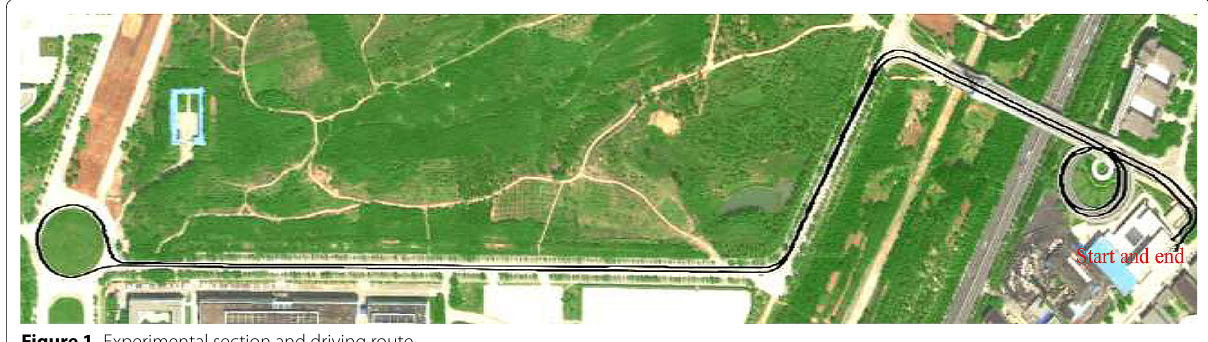
Figure 1 Experimental section and driving route